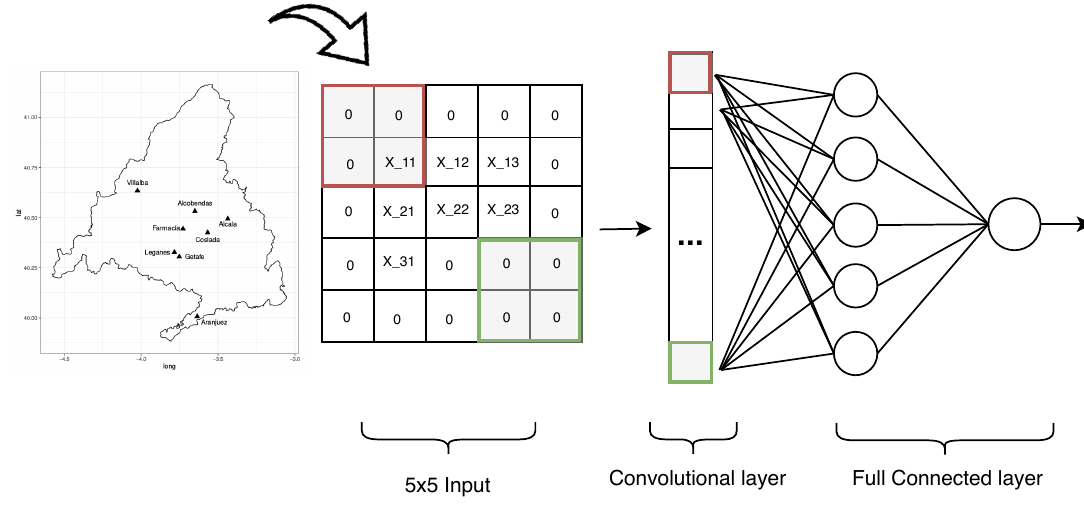
Figure 2. Convolutional neural network.